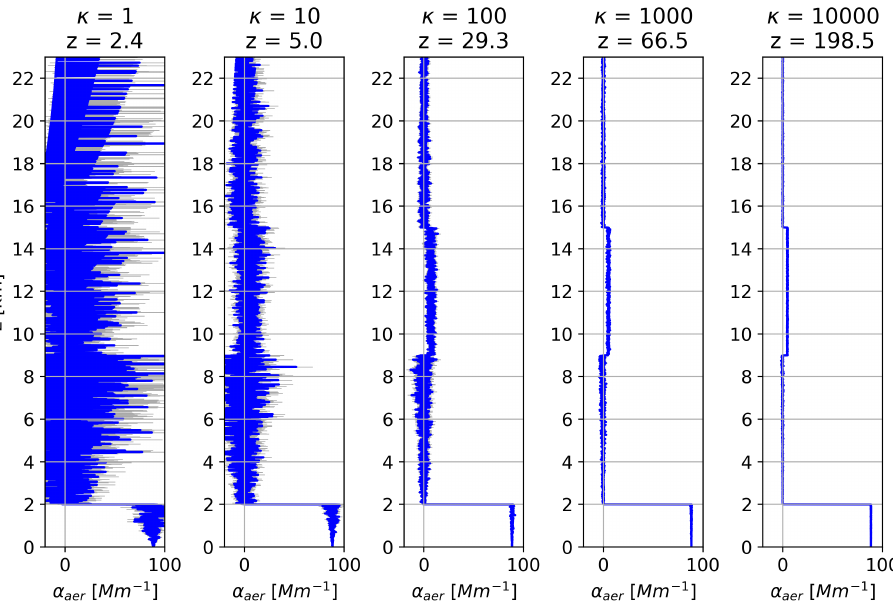
Figure 3. Example of extinction profiles obtained by the Klett–Fernald inversion of lidar signals simulated with κ varying from 1 to 10,000, and ν = 16. Although the Monte Carlo method varies the simulated L aer , here α aer is held constant to allow a direct comparison between panels. The inversion used the exact average value of the L aer at the UT (22